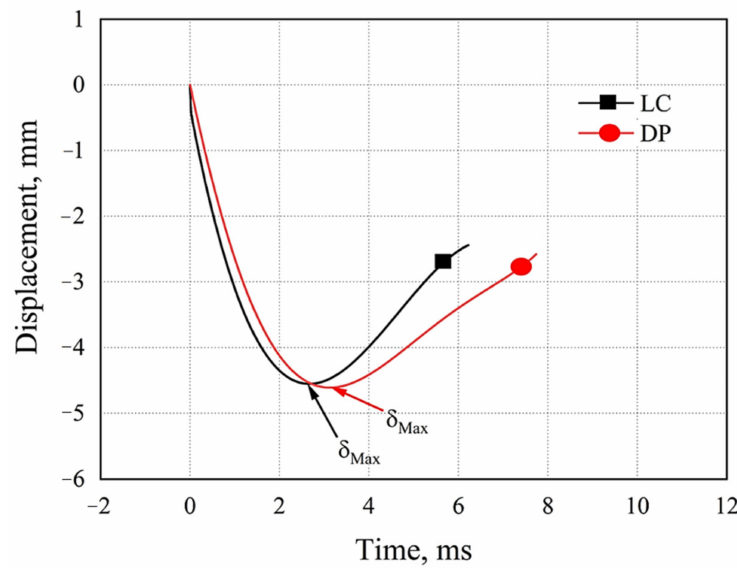
Figure 10. Displacement during the impact test on LC and DP